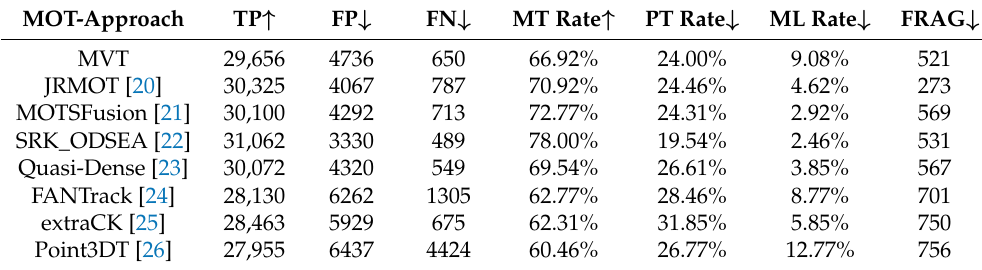
Table 2. Comparison results of several algorithms for seven metrics such as TP.